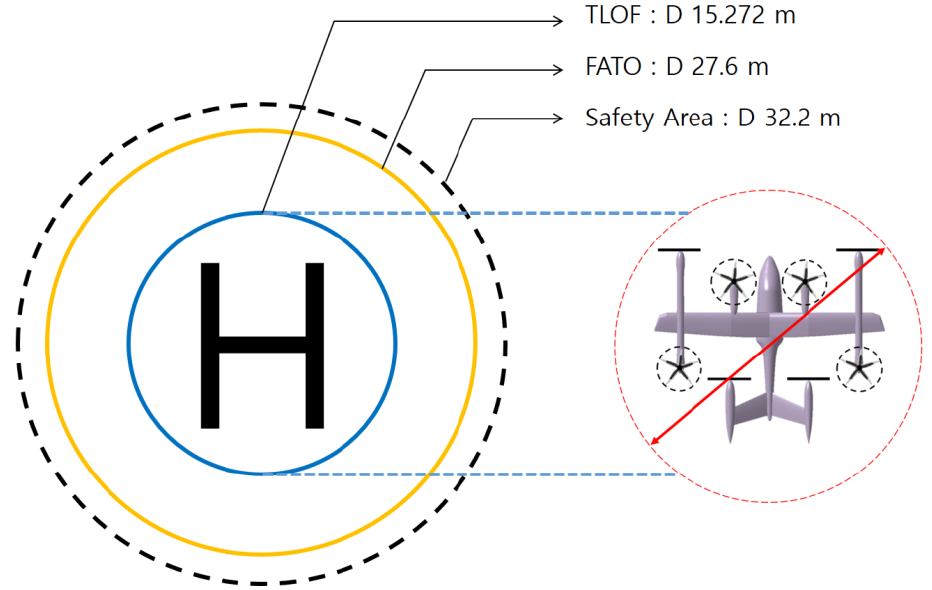
Figure 3. Vertipad size for S-A1 that comply with the EASA’s new regulations.